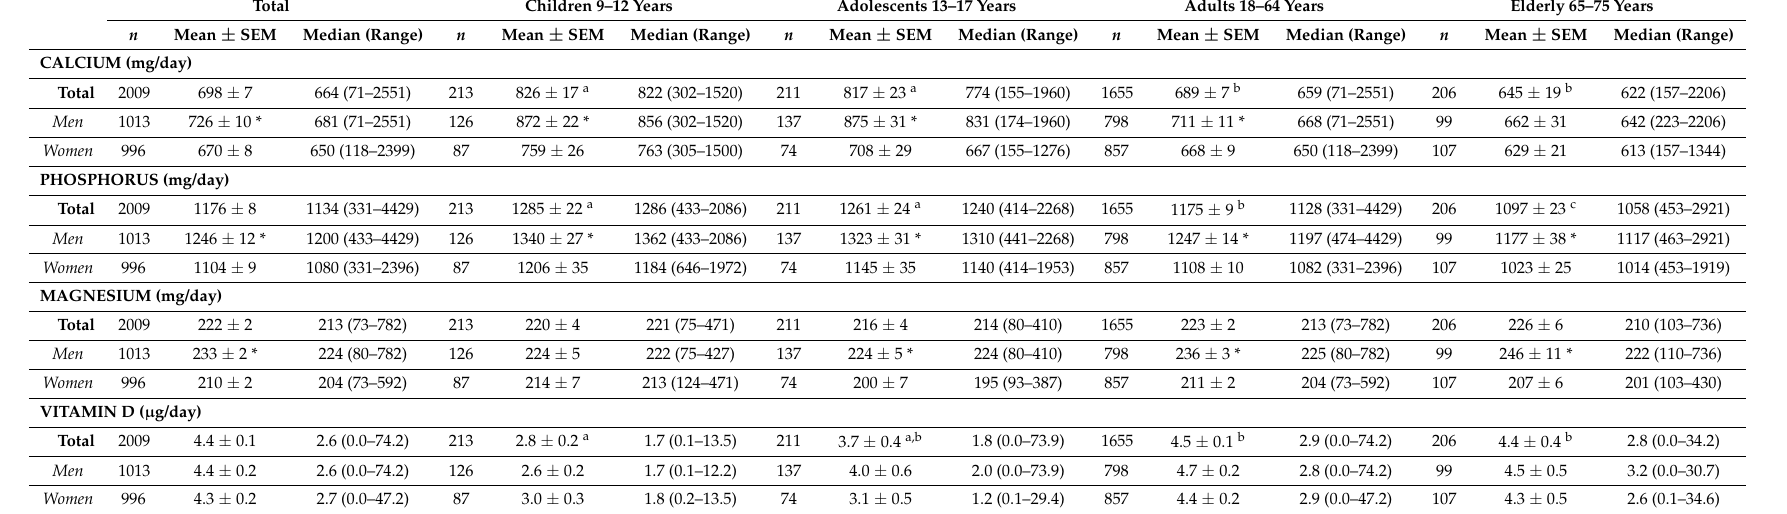
Table 2. Daily calcium, phosphorus, magnesium and vitamin D reported intake by sex and age group in the ANIBES Study